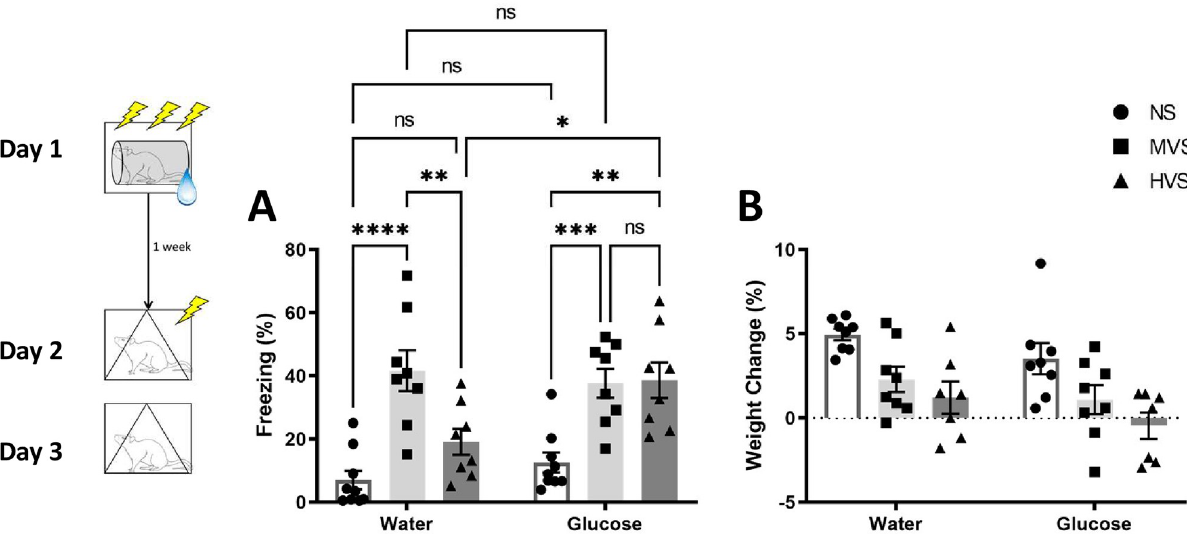
Fig 3. Impacts of glucose ingestion on the fear learning and weight maintenance stress volume effects. Depicted: Percent freezing during context conditioning test (panel A) and weight change one week following stress exposure (panel B). Rats were exposed to 0 (NS), 15 (MVS), or 100 (HVS) tail shocks one week prior to fear conditioning testing. Following stress exposure, all groups received 18-hour free access to a 40% glucose solution or tap water, based on experimental condition. All bottles were then switched back to tap water for the remainder of the experiment. Testing consisted of exposure to a single, 1 mA shock in a novel context. Rats were then returned to this same context 24-hours later. Rats were weighed prior to stress exposure and prior to fear conditioning testing. In groups that received water only, the MVS group spent more time freezing during the context test, when compared to NS and HVS groups. However, in groups that received post-stress glucose, both MVS and HVS groups exhibited freezing levels higher than the NS group. Regardless of fluid condition, both the HVS and MVS groups showed significantly less weight gain when compared to the NS group. Error bars denote mean ± SEM. � p < .05, �� p < .01, ��� p < .001, ���� p <